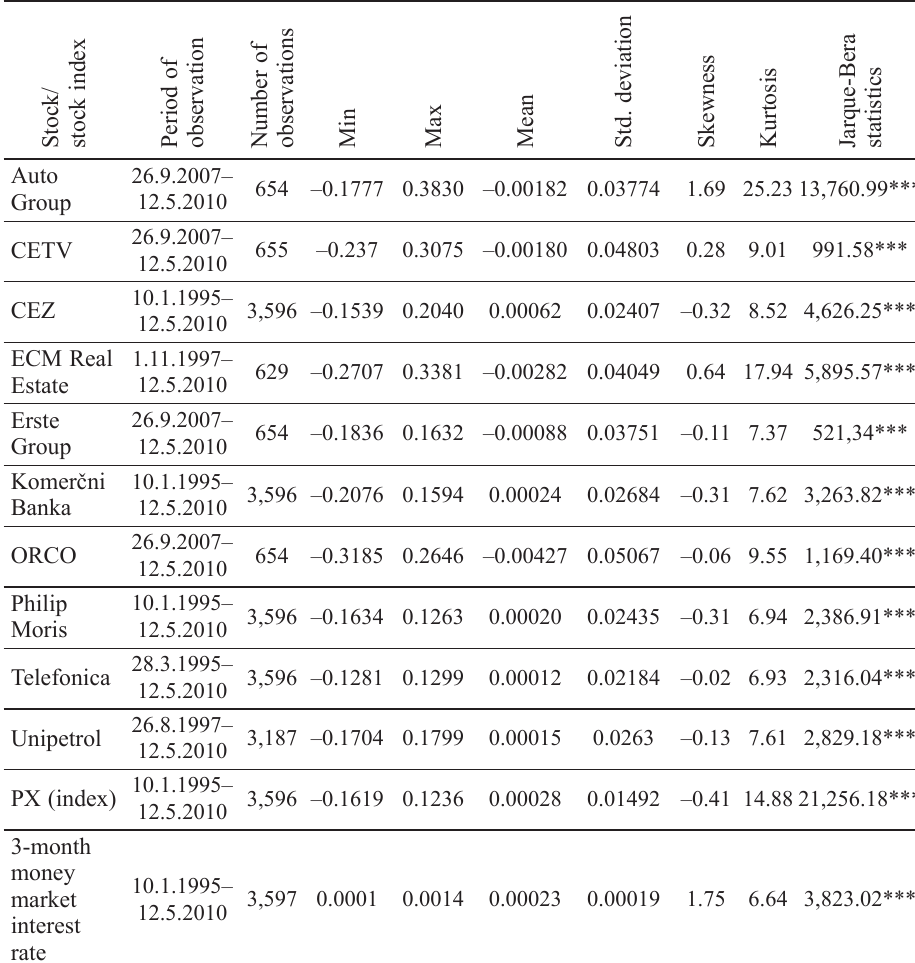
Table 3. Descriptive statistics for returns series of stocks listed at the Czech stock exchange and its representative national stock